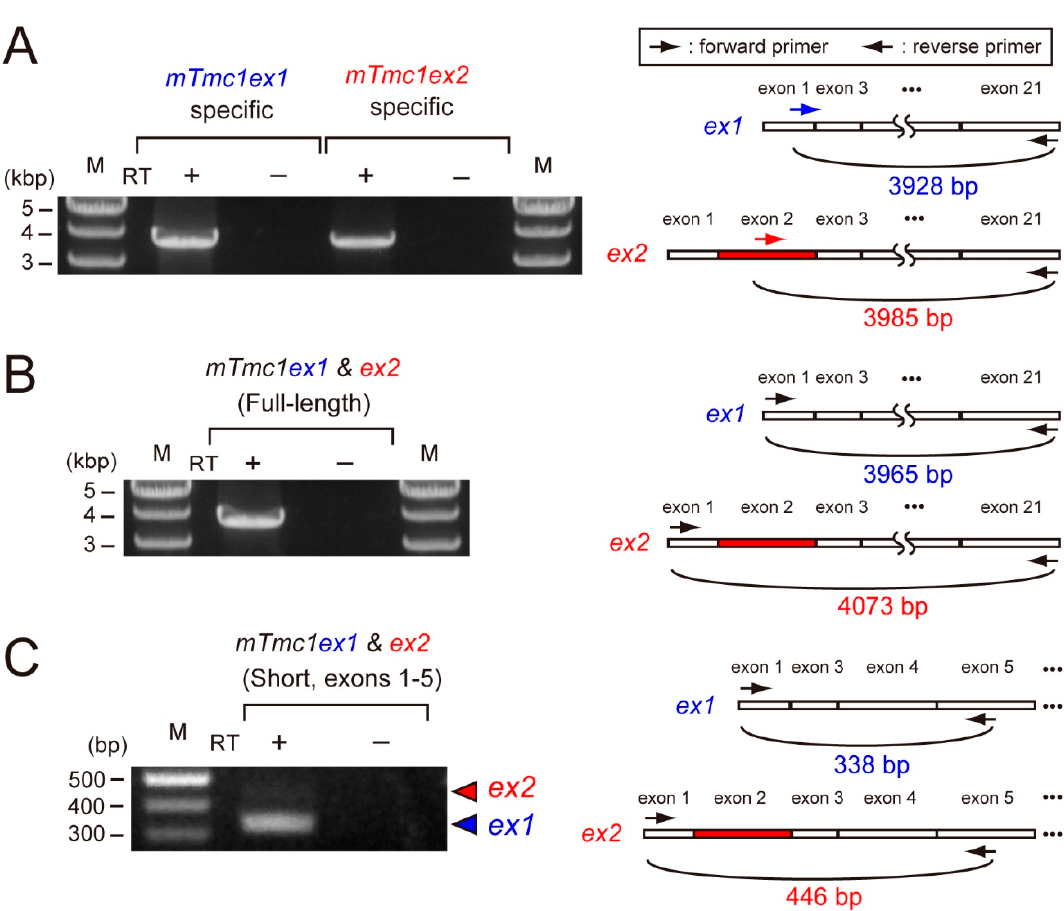
Figure 2. mTmc1ex2 was expressed in the cochlea of 5-week-old mice, but the expression level of mTmc1ex2 was lower than that of mTmc1ex1: ( A ) the result of RT-PCR using RNA extracted from the cochlea of a 5-week-old mouse and primer pairs with which either mTmc1ex1 or mTmc1ex2 can be amplified selectively ( left ). Positions of primers are shown as arrows in the illustrations of mTmc1ex1 and mTmc1ex2 ( right ). The forward primer for mTmc1ex1 is an mTmc1ex1 -specific primer as it spans exon 1 and exon 3 ( right upper ). The forward primer for mTmc1ex2 is an mTmc1ex2 -specific primer as it binds to exon 2 ( right lower ). M: marker. RT: reverse transcription. No amplification in the sample using mRNA as a template (RT − ) indicates that the amplicon in the sample using cDNA as a template